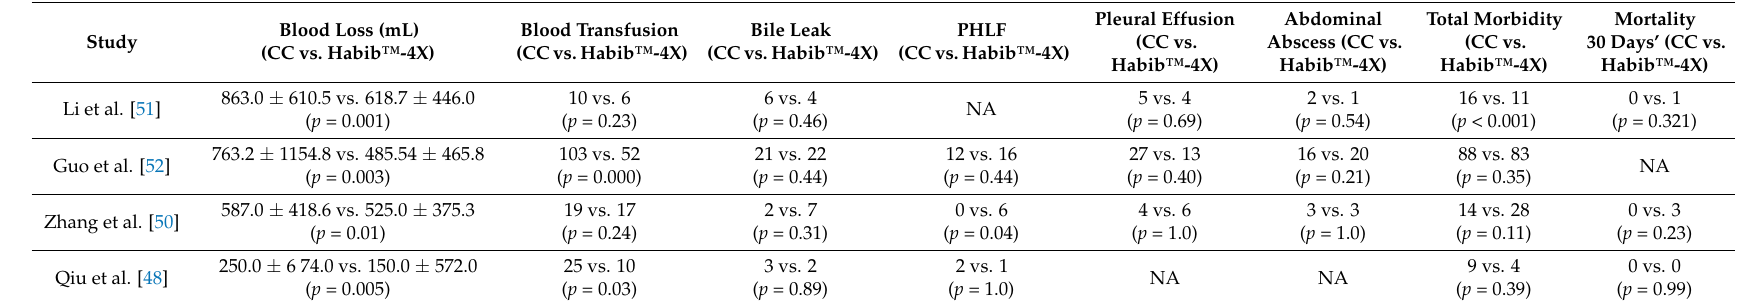
Table 3. Post-hepatectomy analysis of outcomes in included